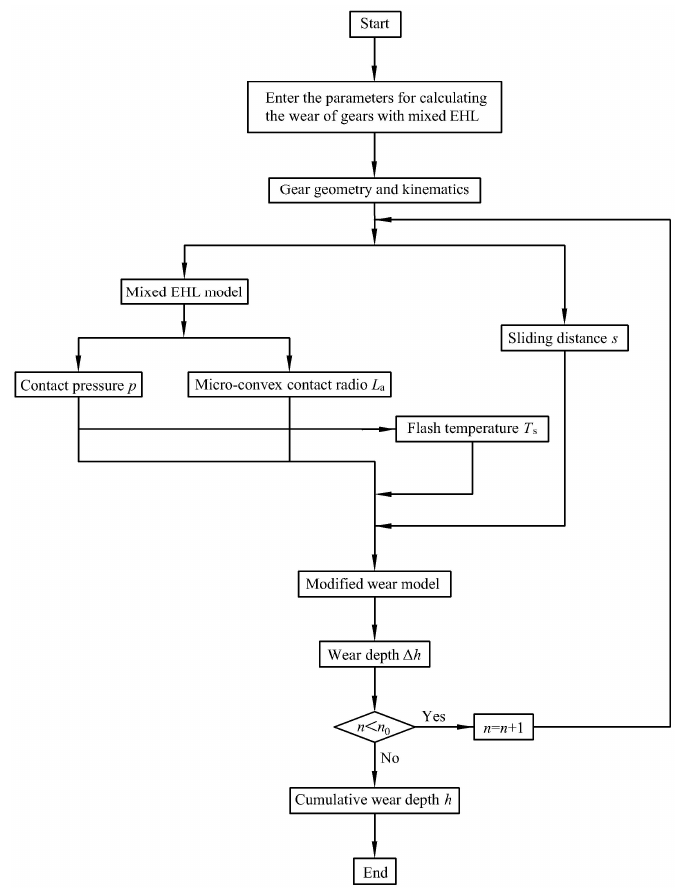
Figure 2. Flowchart of the calculation of the gear wear under mixed elastohydrodynamic lubrica- tion.